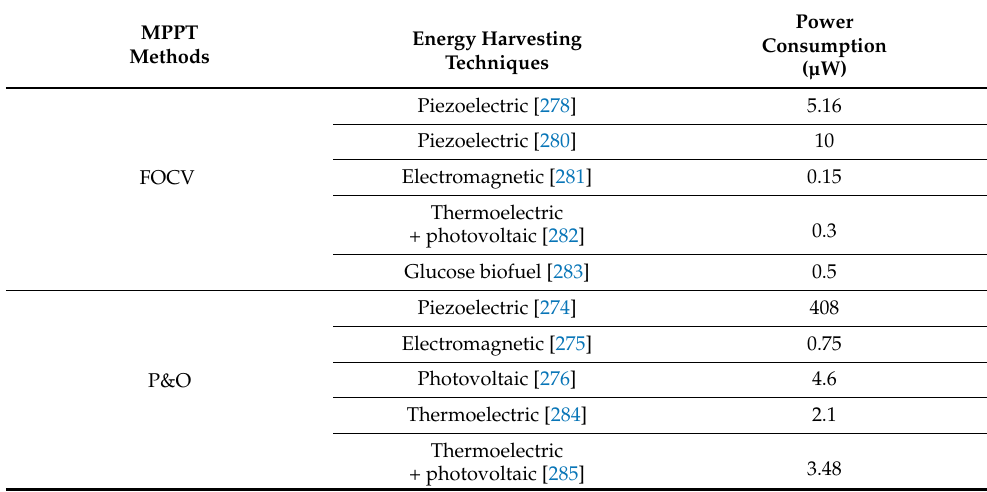
Table 3. Summary of maximum power point tracking approaches and their power